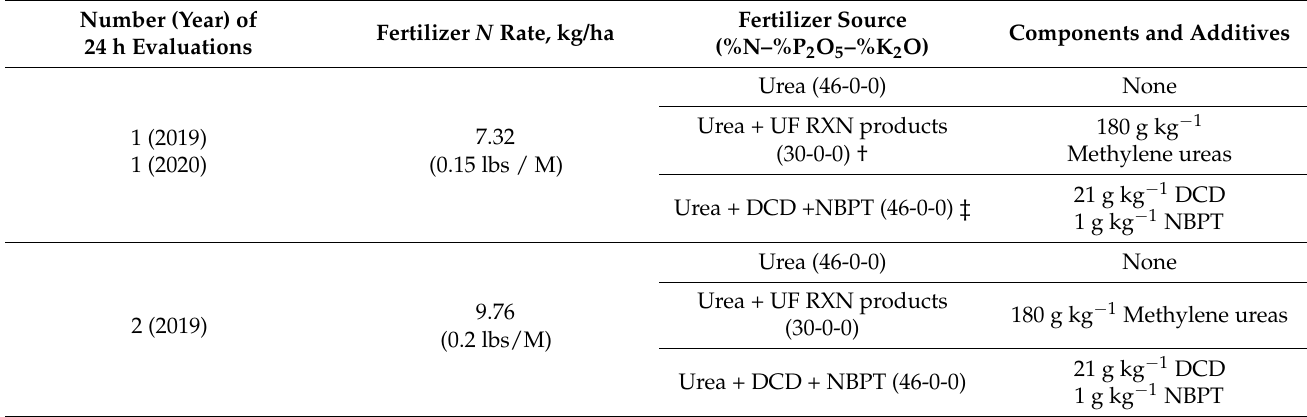
Table 1. Years, runs, fertilizer sources and rates, and fertilizer components and additives employed in the experimental trial. Number (Year) of Fertilizer N Rate, 24 h Evaluations